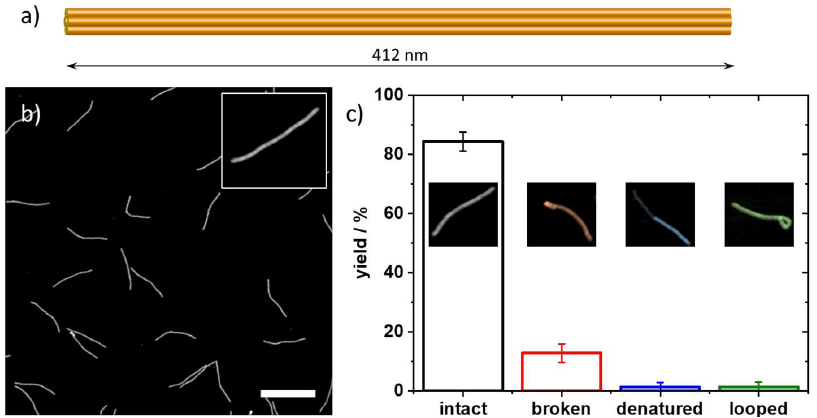
Figure 5. ( a ) Schematic illustration and ( b ) AFM image of DNA origami 6HBs assembled from 56-month-old staples after rinsing. The scale bar and height scale are 500 and 2.0 nm, respectively. The inset shows a zoom of an individual 6HB. ( c ) Corresponding yields of intact, broken, denatured, and looped DNA origami 6HBs. The insets show examples of the individual categories. Sca ff old age at the time of use was one